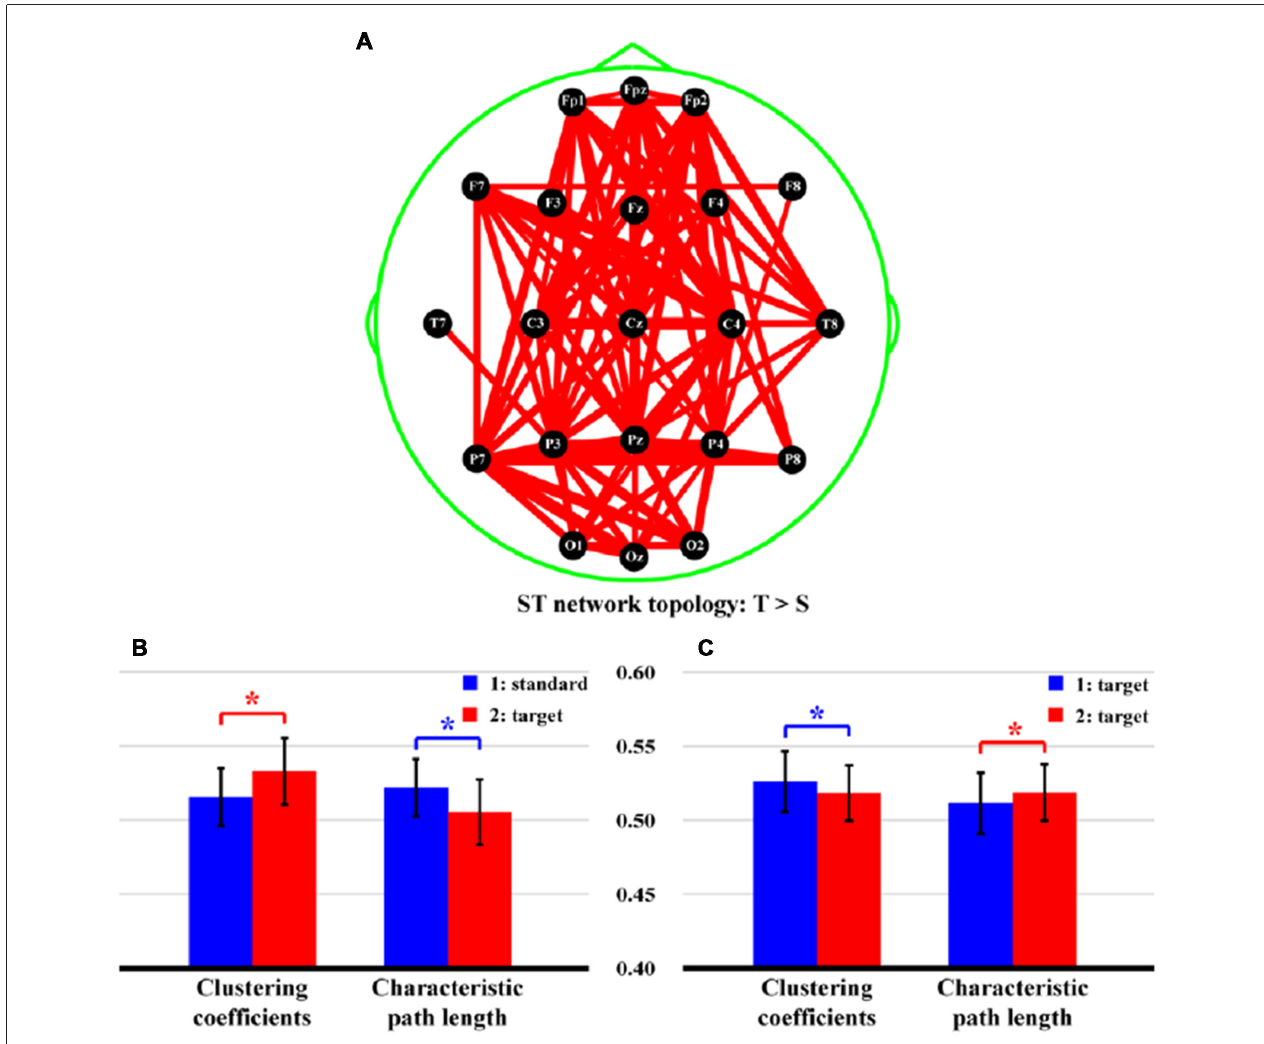
FIGURE 5 | Differences of network topologies and properties between two stimuli in both ST and TT sequences. (A) Network topology of ST sequence. (B,C) Network properties of ST and TT sequences, respectively. In (A) , the red lines denote the stronger network edges of T than that of S stimulus; and the line widths denote the quantitative differences of edge strengths between two stimuli. In (B,C) the blue and red bars denote the network properties of first and second stimulus, respectively. ∗ Indicates p < 0.05. Error bars denote the standard deviations of network properties among 22 subjects. Values are the means and standard deviations (Mean ± SD) of network